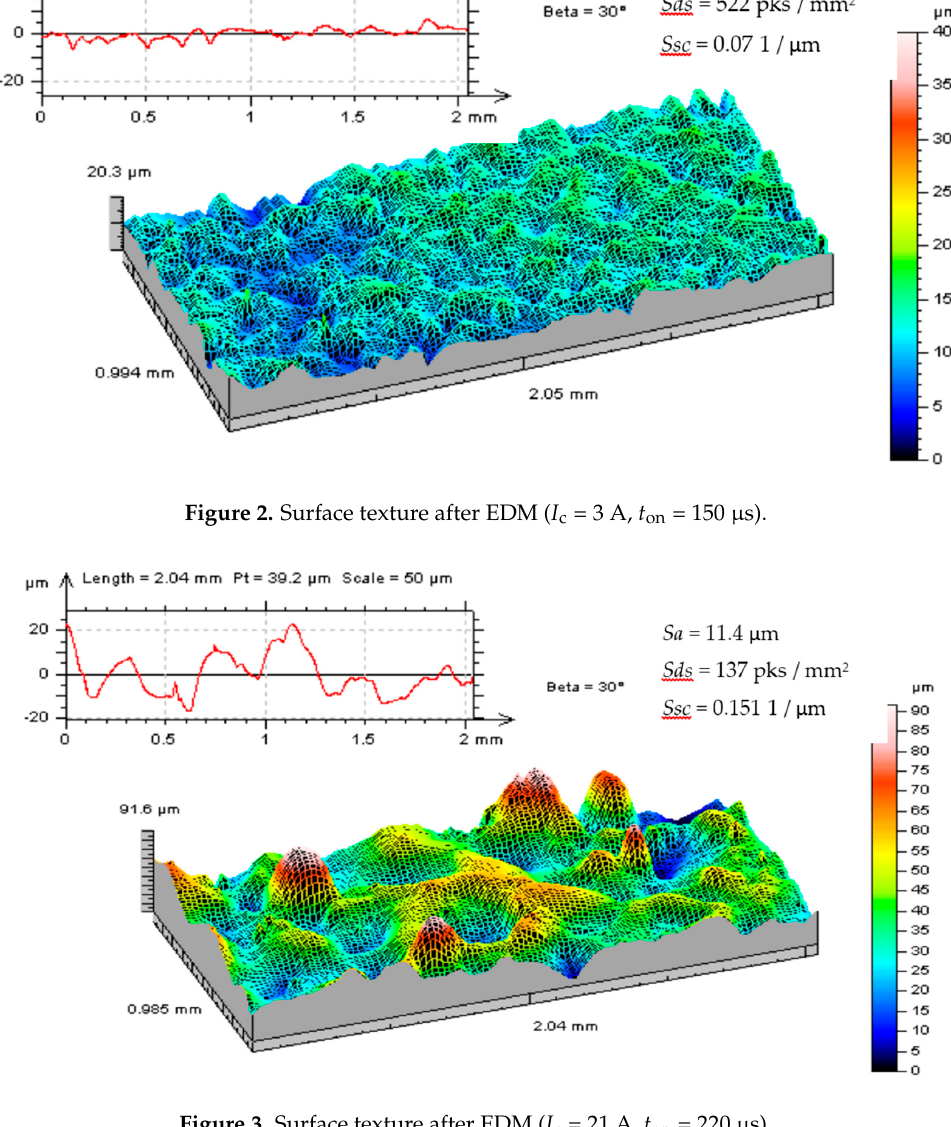
Figure 3. Surface texture after EDM ( I c = 21 A, t on = 220 µs).